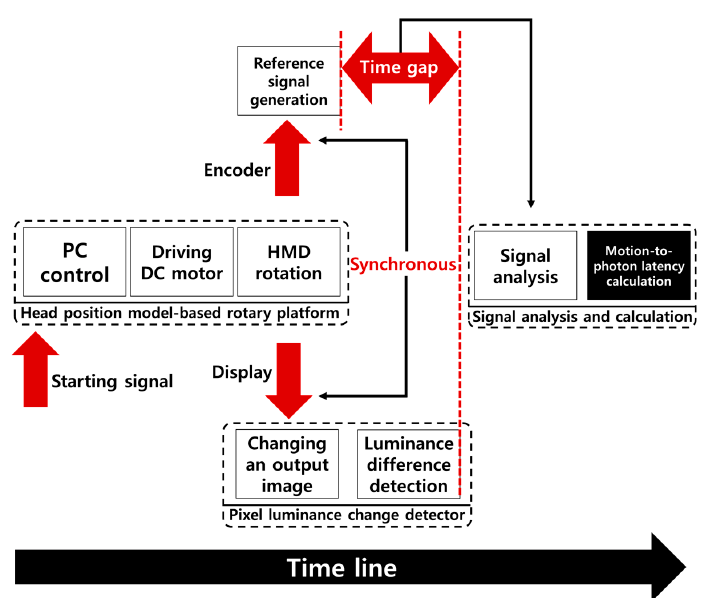
Figure 5. Overall procedure of the proposed system.